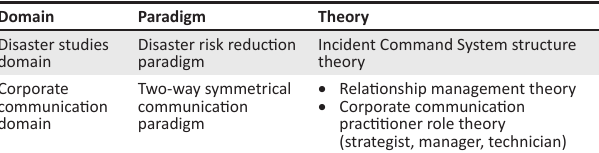
TABLE 1: Theoretical framing of the research